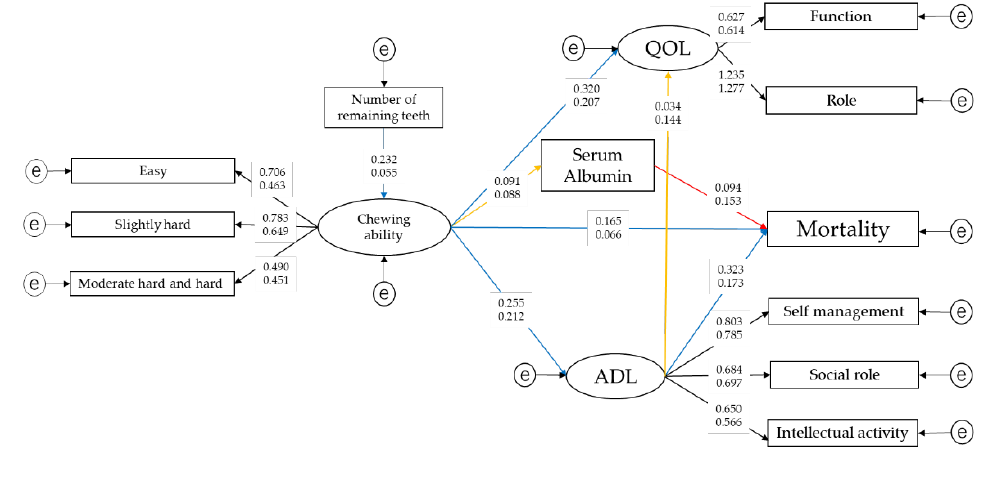
Figure 5. Overview of the interactions among health-related factors. Black lines indicated statistical significance for both men and women, blue lines indicate significance only in men, red lines indicate significance only in women, and orange lines indicated no significance for either men or women. e: